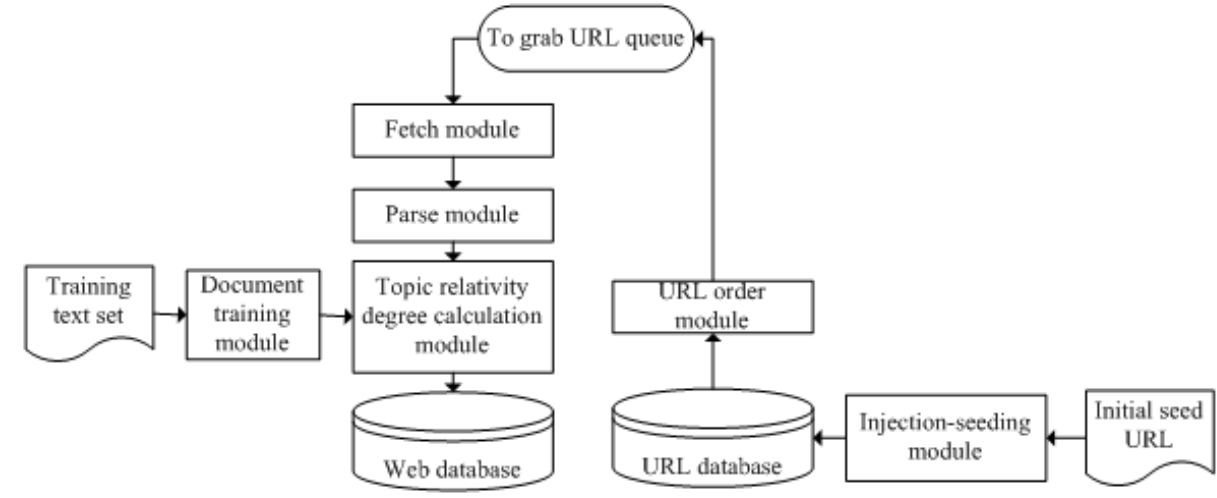
Figure 1. The structure of topic-focused web